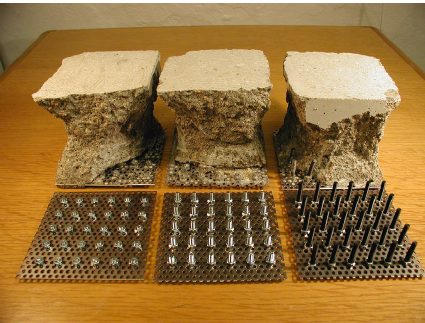
Figure 6: Cement mortar specimens containing steel needles after the final destructive tests.